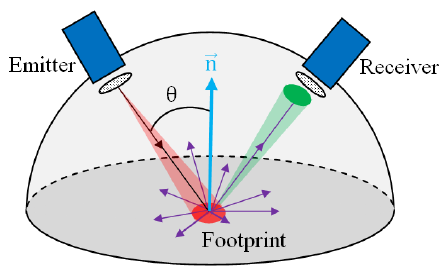
Figure 1. Reflected laser shots by extended Lambertian targets are uniformly scattered into a hemisphere. n is the normal vector, and θ is the incidence angle. In most cases of TLS (terrestrial laser scanning), the emitter and receiver coincide.